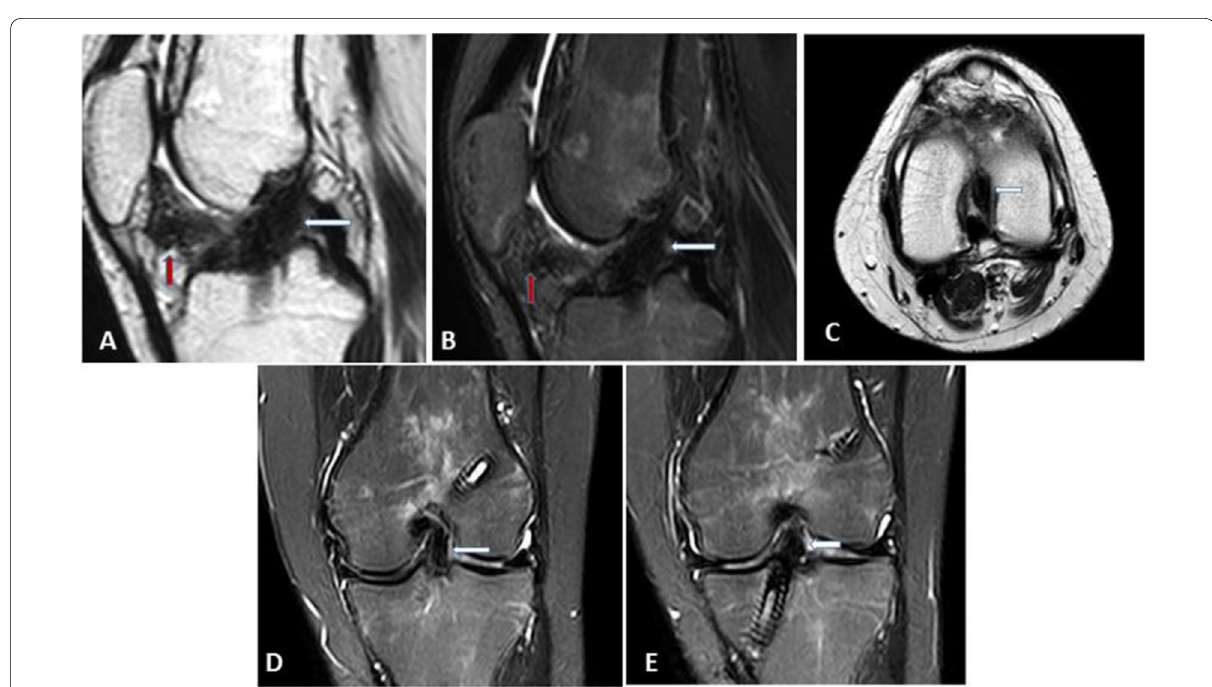
Fig. 5 Female patient, 22 years old with left ACL reconstruction. She came now complaining of pain and limitation of movement. A , sagittal T2; B , sagittal T2 fat sat; C , axial T2; D and E coronal T2 fat sat WIs (protocol A) showing preserved diffuse low signal of the graft with proper graft inclination suggesting grade 0 injury (white thick arrows). Associated localized arthrofibrosis of Hoffa’s fat pad is also seen (thick red